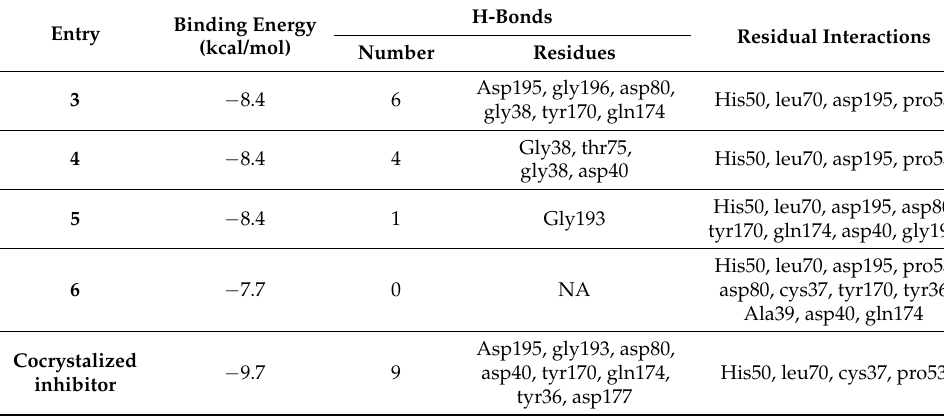
Figure 10. 2D ( B ) and 3D ( A ) representation of Nmt docked with its cocrystalized inhibitor. Table 2. Docking results of new compounds with TyrRS.